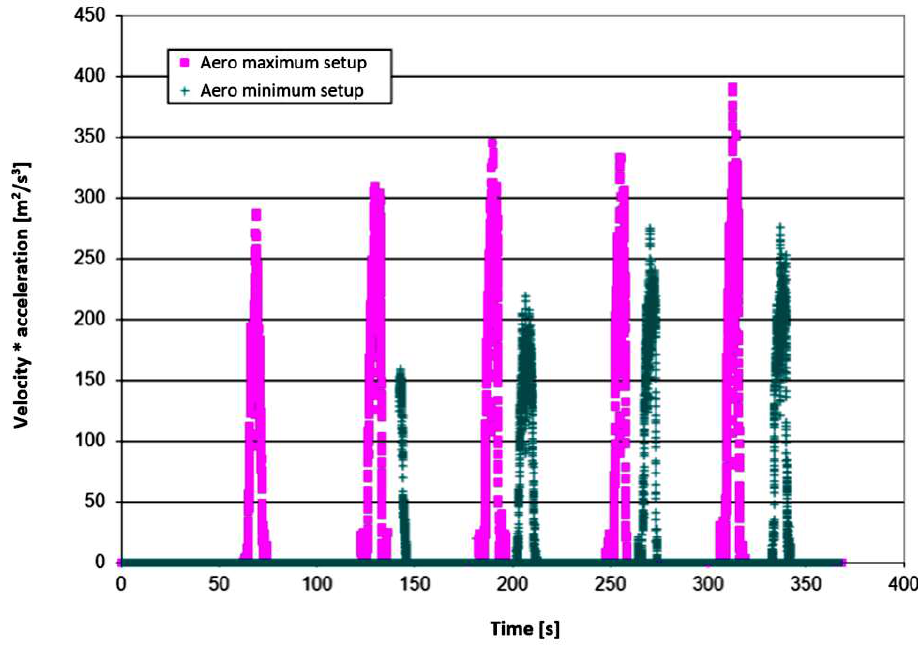
Figure 37. The product of the speed and the lateral acceleration during the passage through the curve.